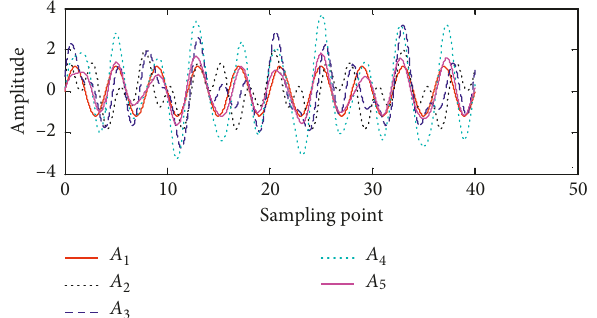
Figure 1: Graphical representation of DSM. A 1 indicates the target signal, A 2 is an interference signal, A 3 represents a mixed signal of A 1 and A 2 , A 4 refers to a superimposed signal after A 3 and A 3 moved to the right for T , and A 5 denotes a separated target